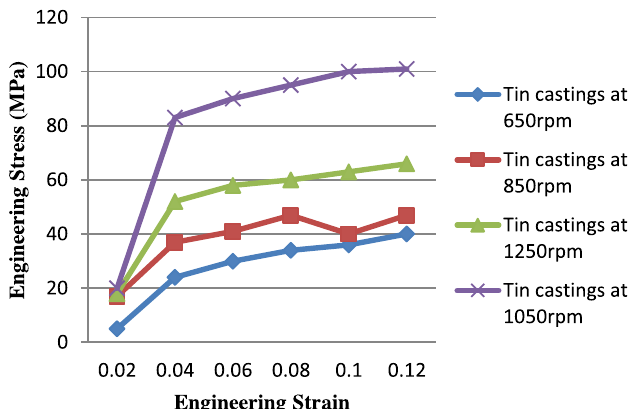
Fig. 9. Engineering stress vs engineering strain for 8mm Tin cast tubes at speeds of 650rpm, 850 rpm, 1050rpm and1250 rpm.